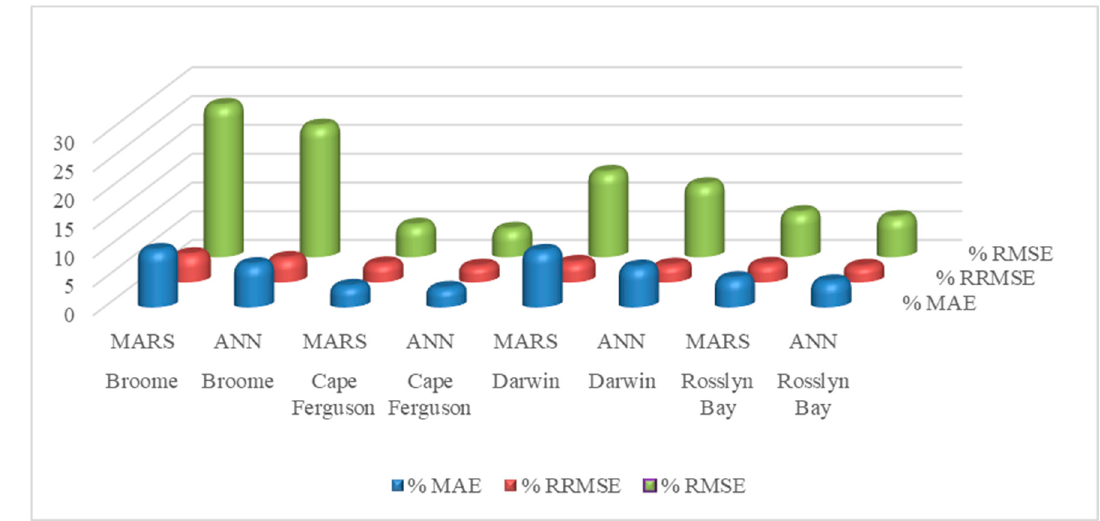
Figure 6. Three-dimensional bar graph of the percentage RMSE, RRMSE, MAE for all study sites generated by MARS and ANN in the testing phase.